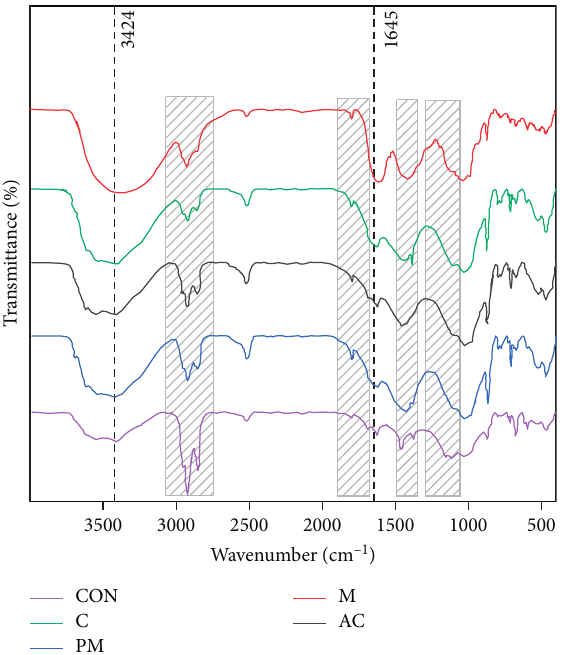
Figure 3: FTIR scans of soil in all treatments over 15